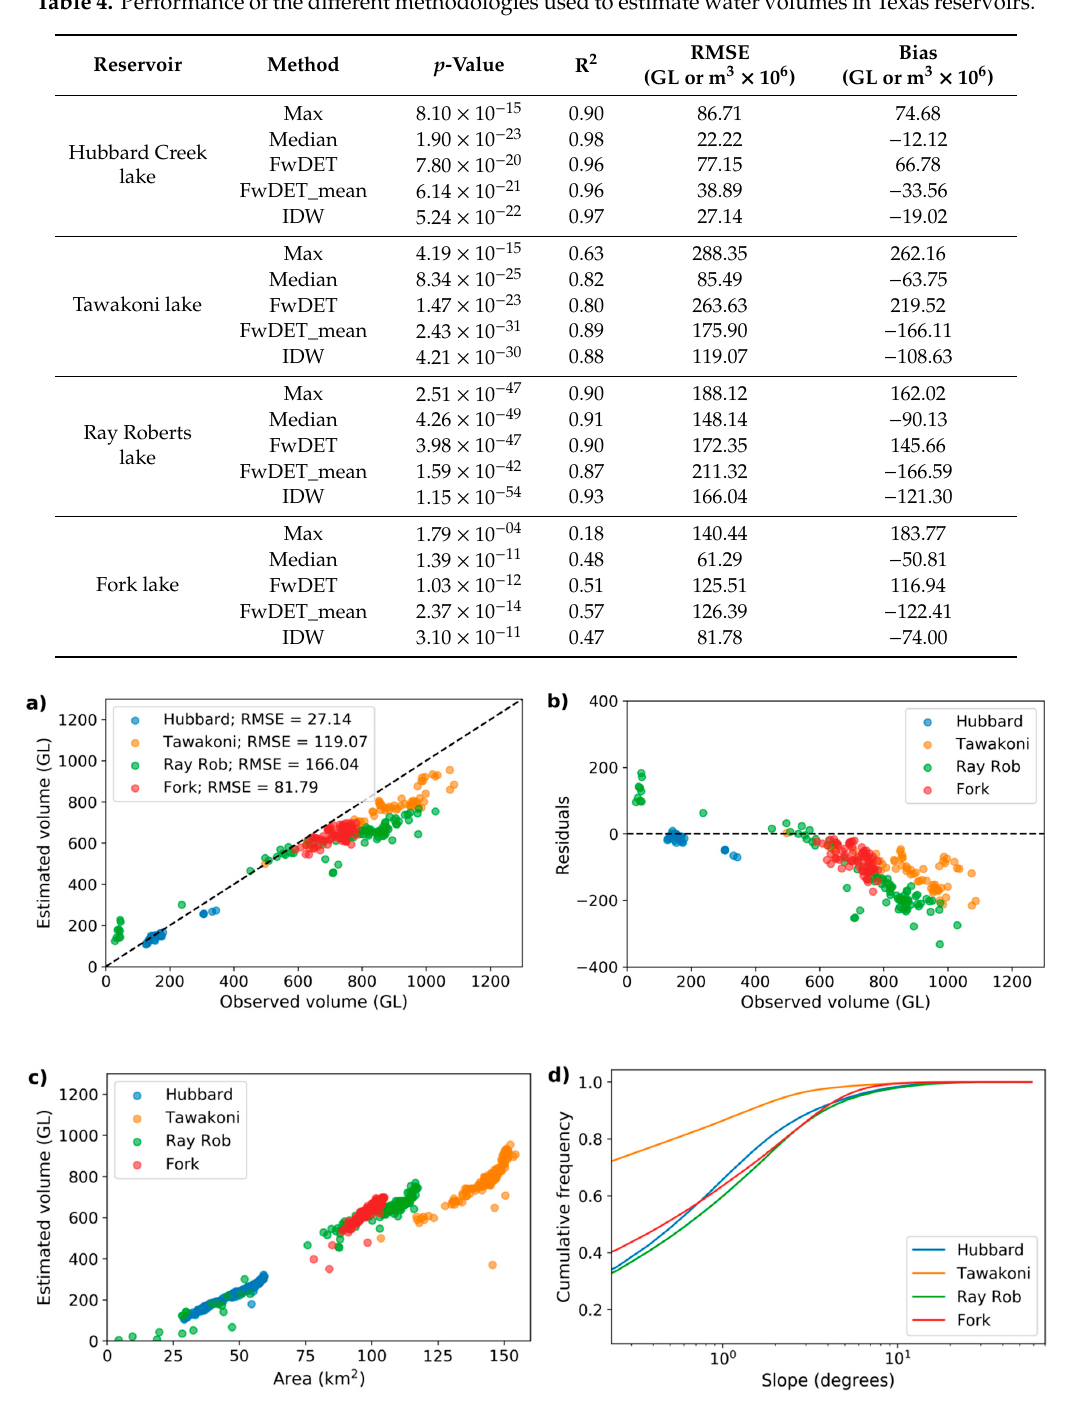
Figure 11. Water volume estimations ( a ), their residuals ( b ), and the area–volume relationship ( c ) obtained using the inverse distance weighting interpolation methodology on the Texas reservoirs. The cumulative frequency of slopes in the reservoirs are also presented ( d